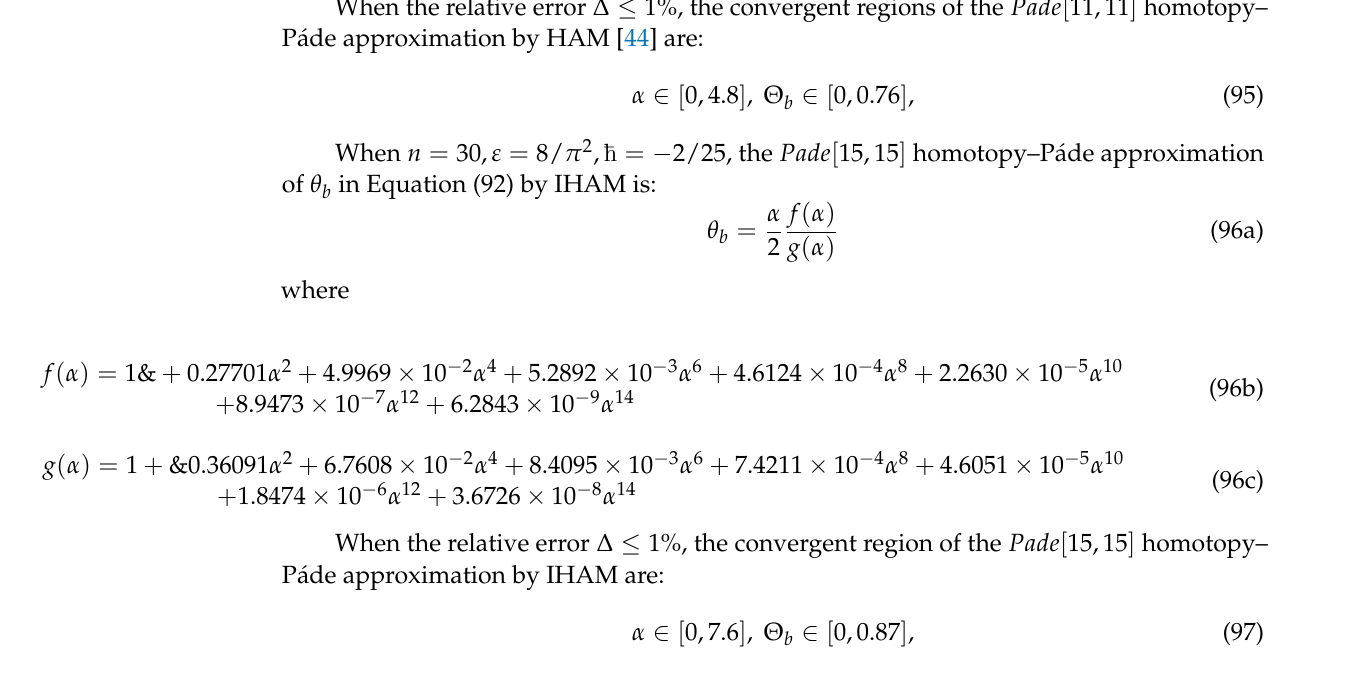
Table 5. Thirtieth homotopy–P á de approximation solutions Θ